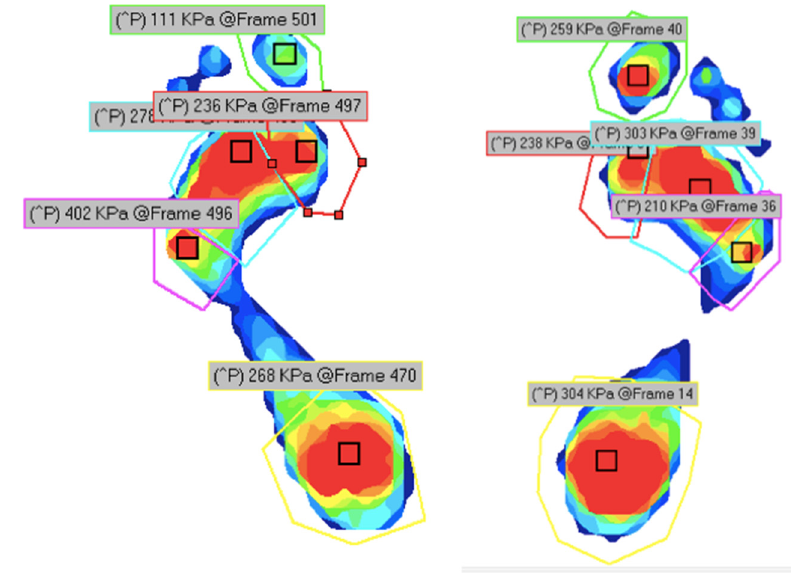
Figure 2. Regions of interest for plantar pressure assessment.